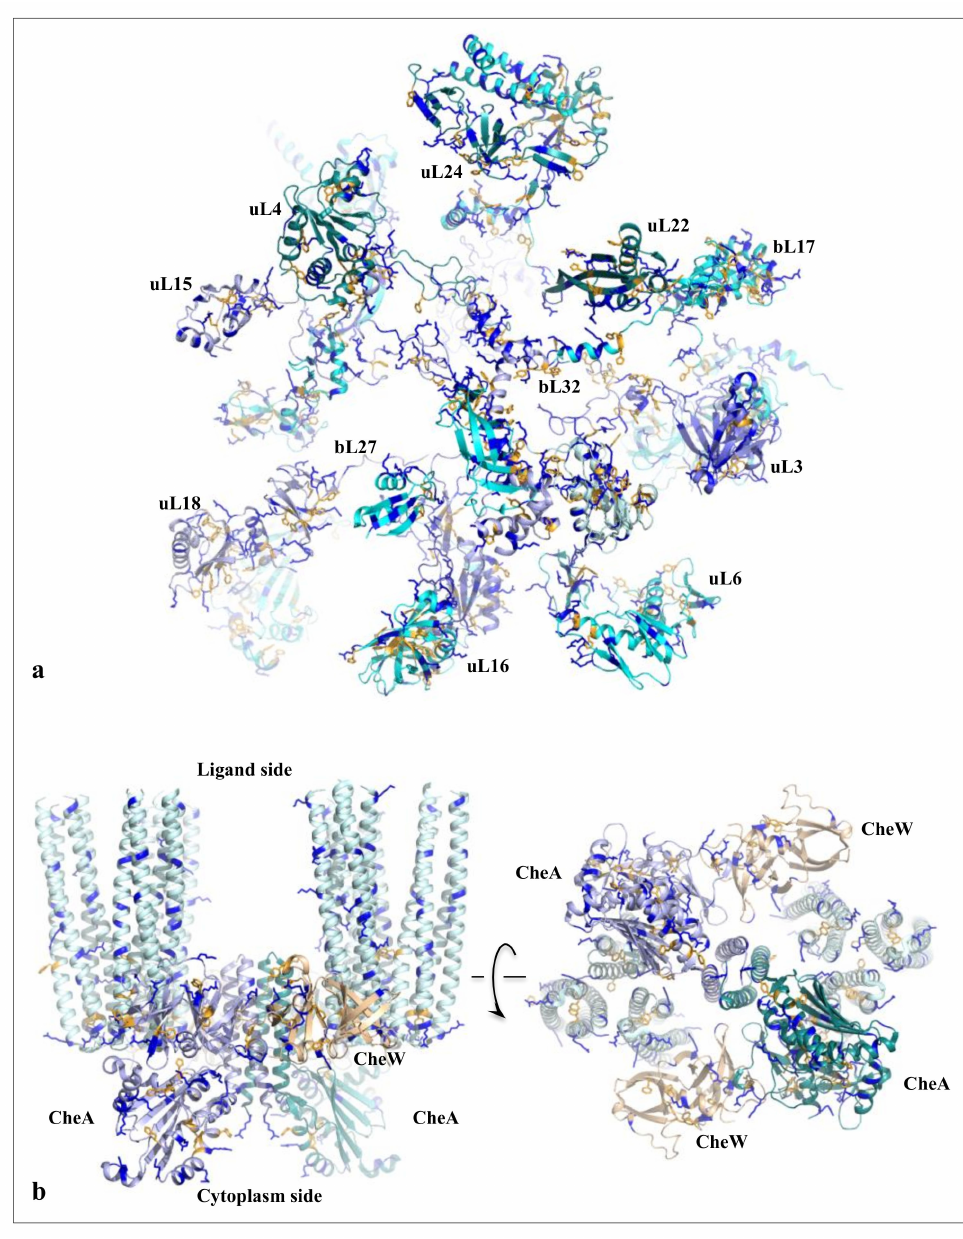
Figure 3. Structural comparison of two molecular brains. ( a ) The r-protein network of the bacterial ribosome (pdb_id 4y4p). For clarity, the rRNA is not represented. ( b ) The structure of a chemosensory array involved in the bacterial chemotaxis (pdb_id 6s1k). Both structures are shown at the same